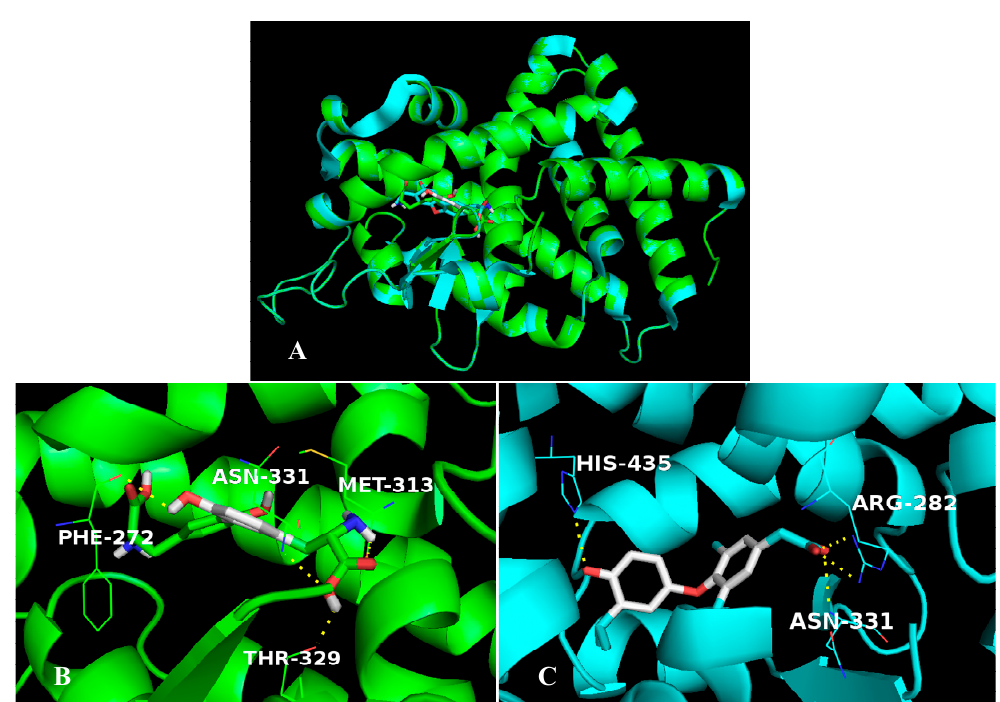
Figure 10. ( A ) Superposition between the crystallographic structures of the complex 1NAX/IH5 with the resultant docking pose of 1NAX/TDT. Crystallographic structure and docking structure are represented in blue and green, respectively. ( B ) The enlargement for ligand TDT in the binding site of 1NAX, which is displayed as stick, hydrogen bonds are shown as dotted yellow lines, and the non-polar hydrogens were removed for clarity. ( C ) The enlargement for ligand IH5 in the binding site of 1NAX, which is displayed as stick, hydrogen bonds are shown as dotted yellow lines, and the non-polar hydrogens were removed for clarity.